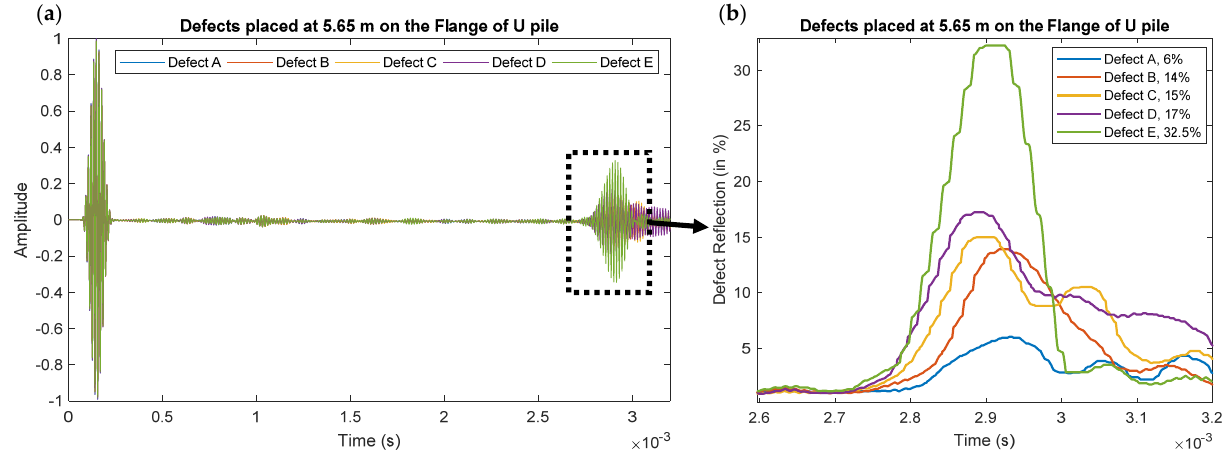
Figure 17. ( a ) Results obtained from the defects placed at 5.65 m on the flange of the U-pile. ( b ) Defect reflection results from the respective defects.